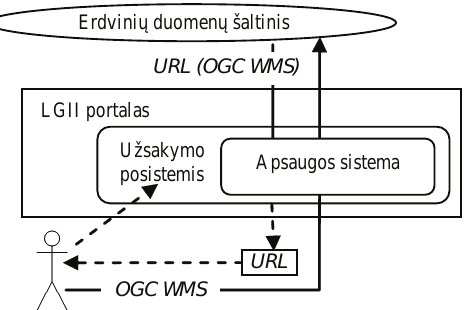
Fig. 3. An example of transferring a web